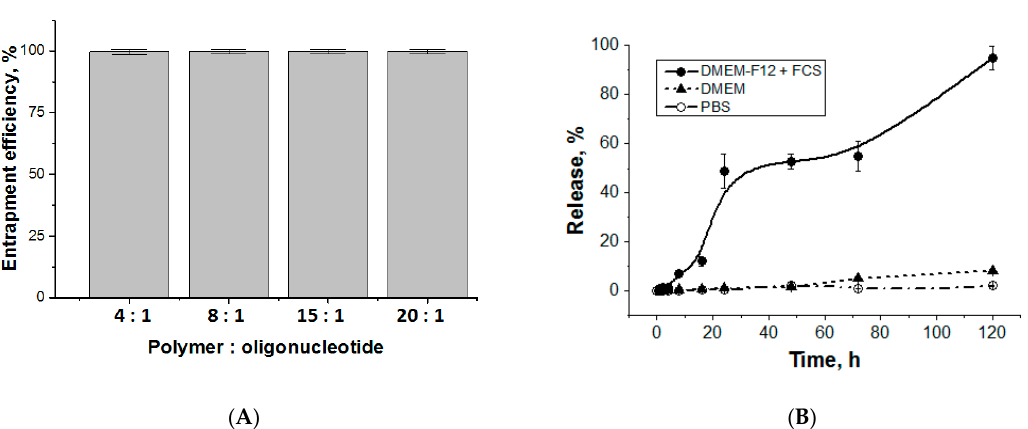
Figure 3. Hydrodynamic diameter ( A ) and surface charge ( B ) of polypeptide nanoparticles (sample KEI2), loaded with duplex oligo-dT-dA.